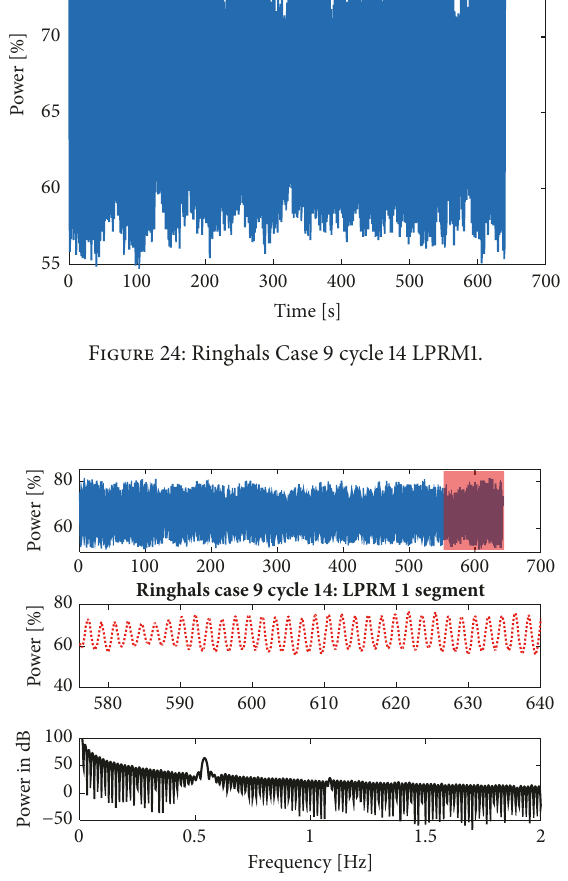
Figure 25: Studied segment of the Ringhals Case 9 cycle 14 LPRM 1.